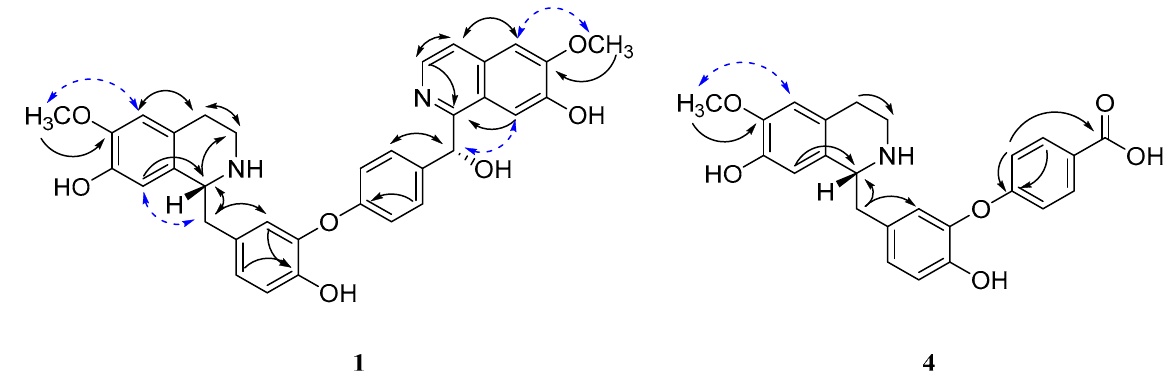
Figure 2. The key HMBC correlations (black) and ROESY correlations (blue) of 1 – 4 .